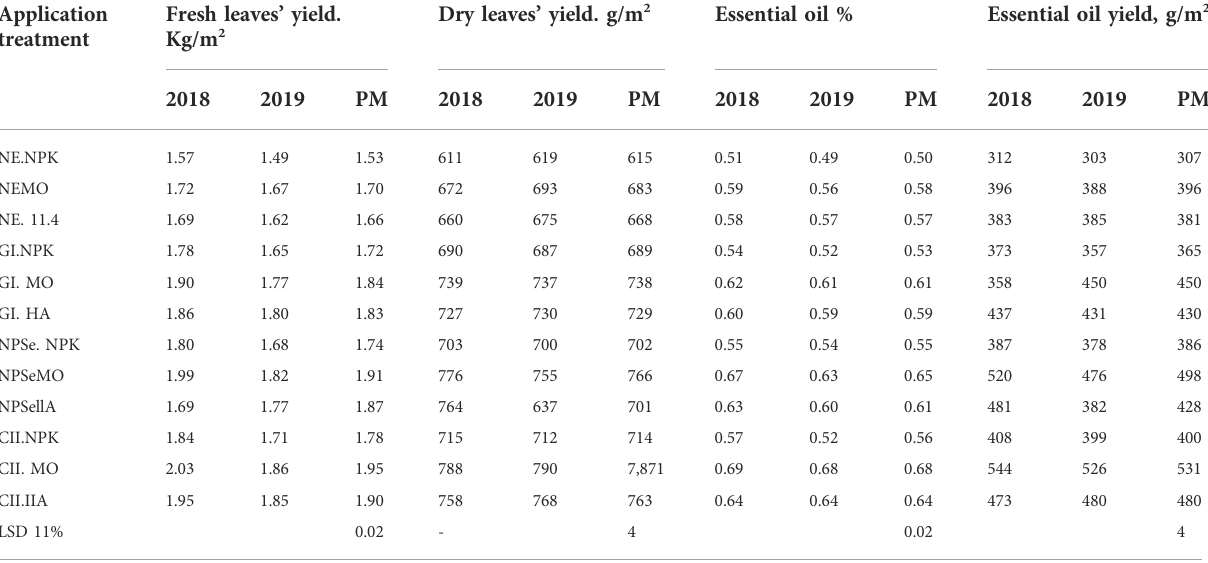
TABLE 1 Artemisia fresh and dry leaves ’ yield, essential oil percentage, and essential oil yield in response to elicitors (GI, NSe, and CH) under (NPK),Moringa (MO), and humic acid (HA) fertilizers. Application Fresh leaves ’ treatment